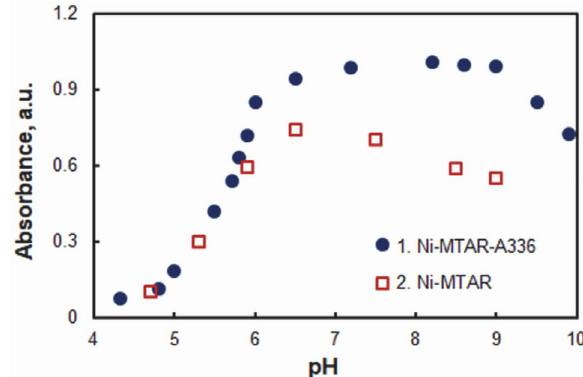
Figure 2. Absorbance of the complex in presence (1) or absence (2) of A336 vs. pH of the aqueous phase. c Ni = 2 × 10 −5 mol dm −3 , c MTAR = 2 × 10 −4 mol dm −3 , c A366 = 5.6 × 10 −3 mol dm −3 , V aq. phase = 10 cm 3 , extraction time t = 60